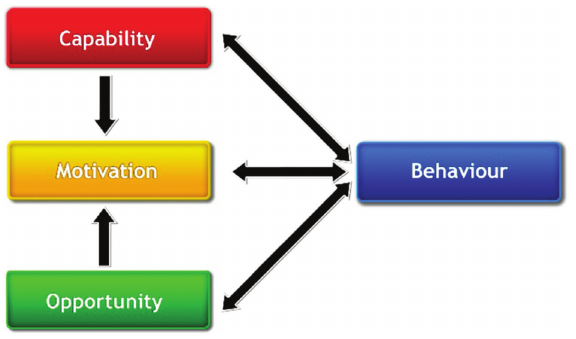
The COm-B model of behaviour [69]. COm-B, Opportunity, motivation Behaviour (COm-B)